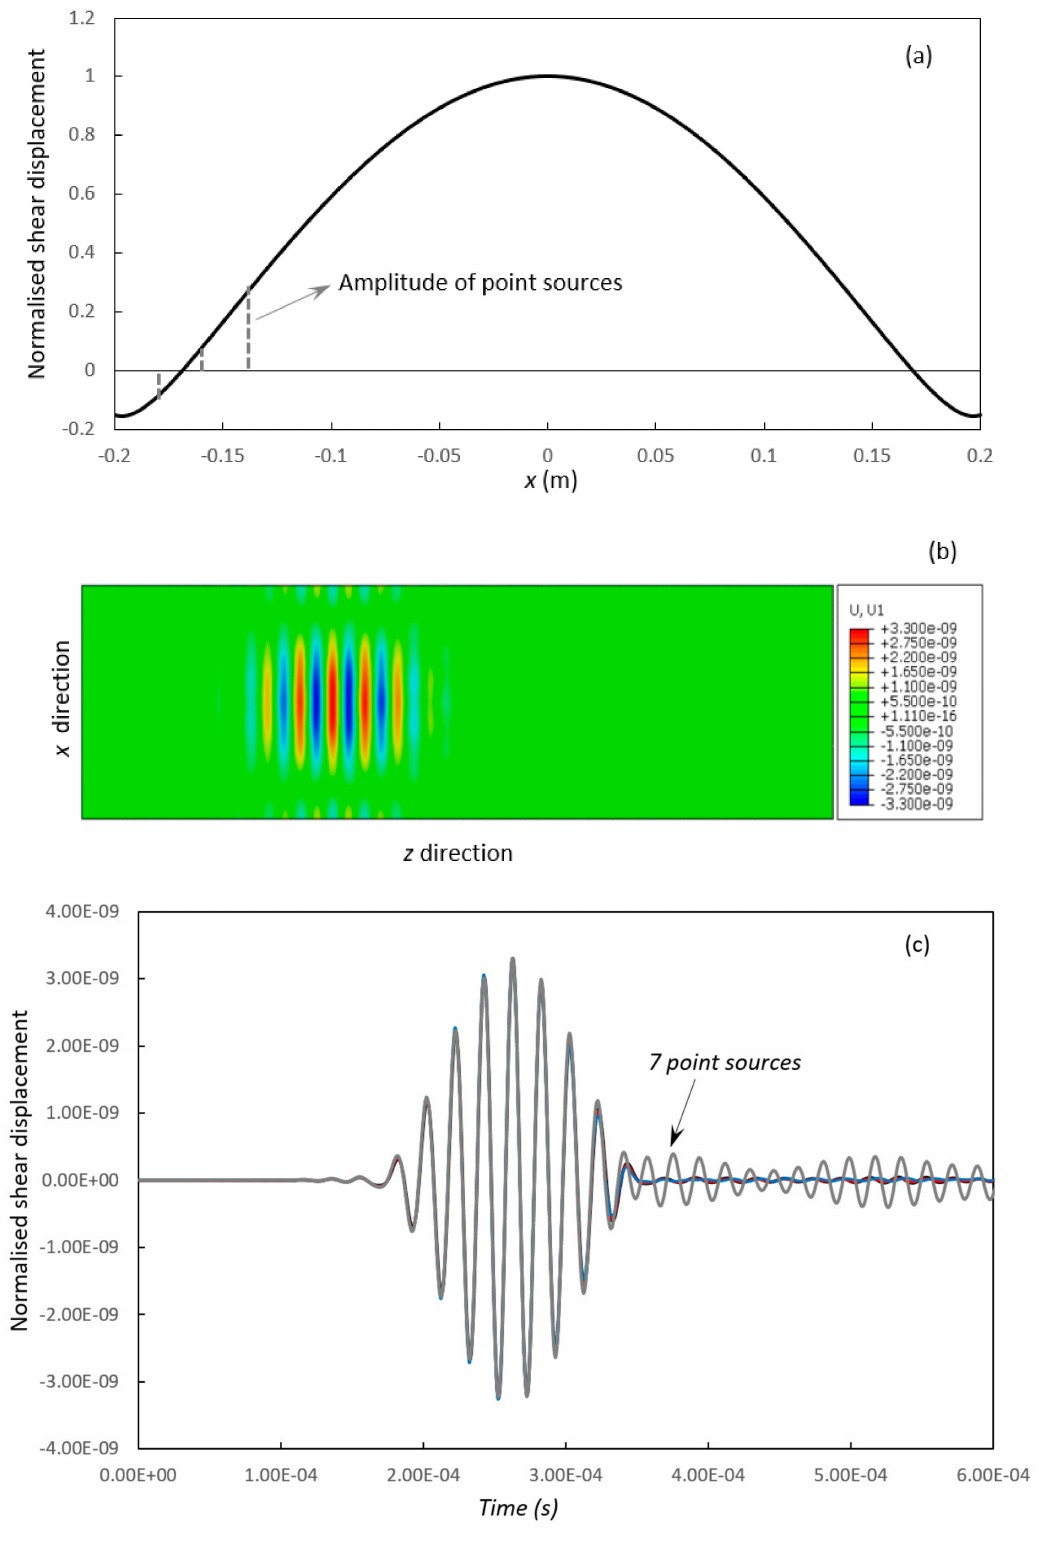
Figure 8. Excitation of shear-type mode SH0*: ( a ) shear displacement loading; ( b ) generated shear displacement distribution (top view); ( c ) time domain displacement at receiver